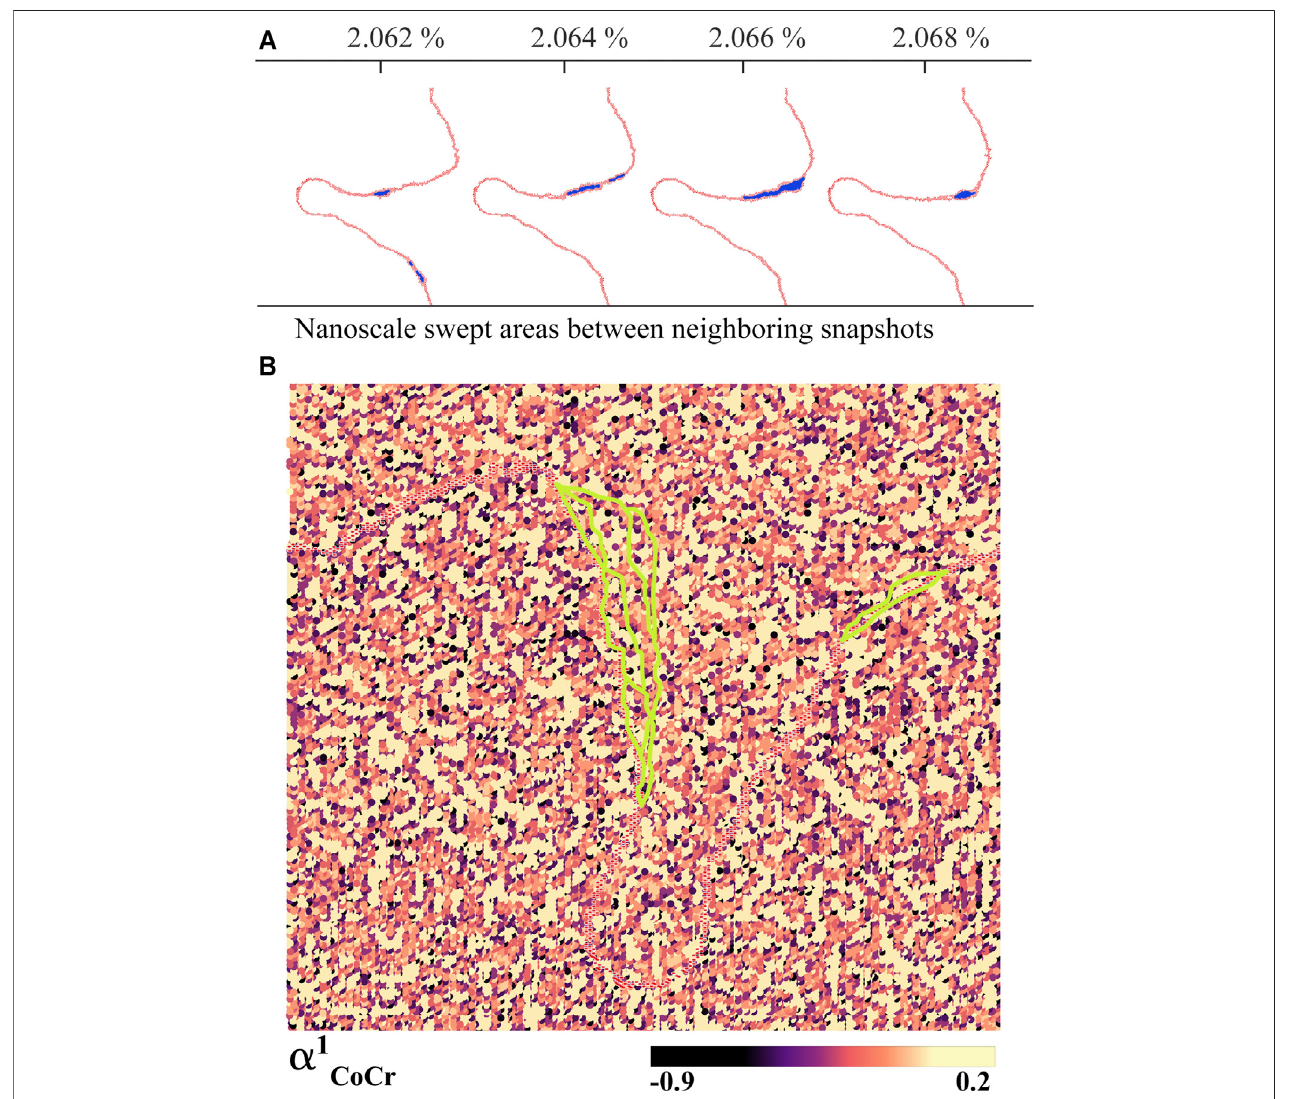
FIGURE 9 | Dislocation motion via nanoscale segment detrapping mechanism for the sample annealed at 450 K (with nanoprecipitates). (A) Snapshots at varying shear strains showing nanoscale segment detrapping process, in which the swept areas between two neighboring snapshots are highlighted in blue color. (B) Correlationbetweennanoscalesegmentdetrappingeventsandspatialdeviationsfromlocalchemicalorderingforthesampleannealedat450